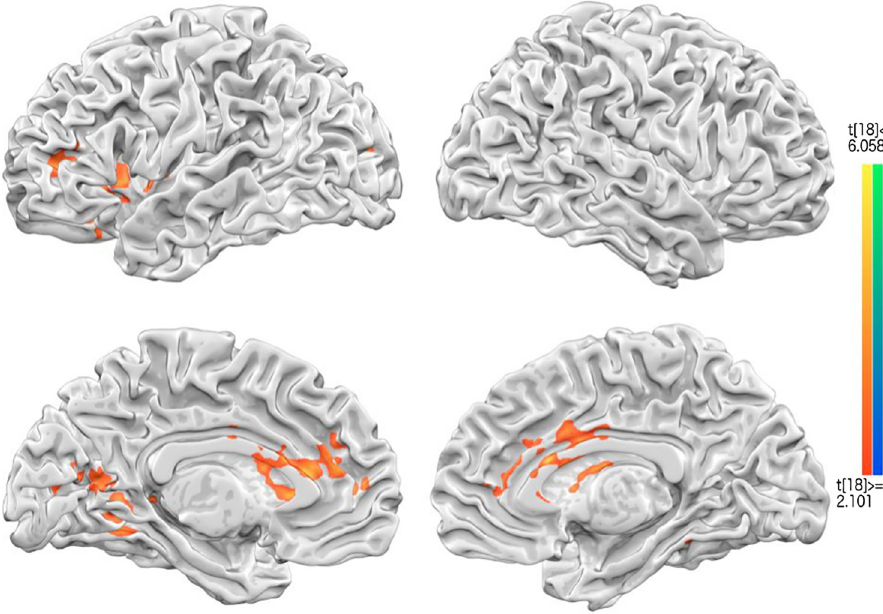
Fig 5. The result of psycho-physiological interaction (PPI). The meta-analysis derived NAcc and VTA (upper panel) were combined to create the seed region. And the functional connectivity analyses were applied. The PPI term revealed the mPFC, Anterior Cingulate Cortex (ACC), and right Insula as the brain regions that are functionally connected with the dopaminergic reward-related seed regions.